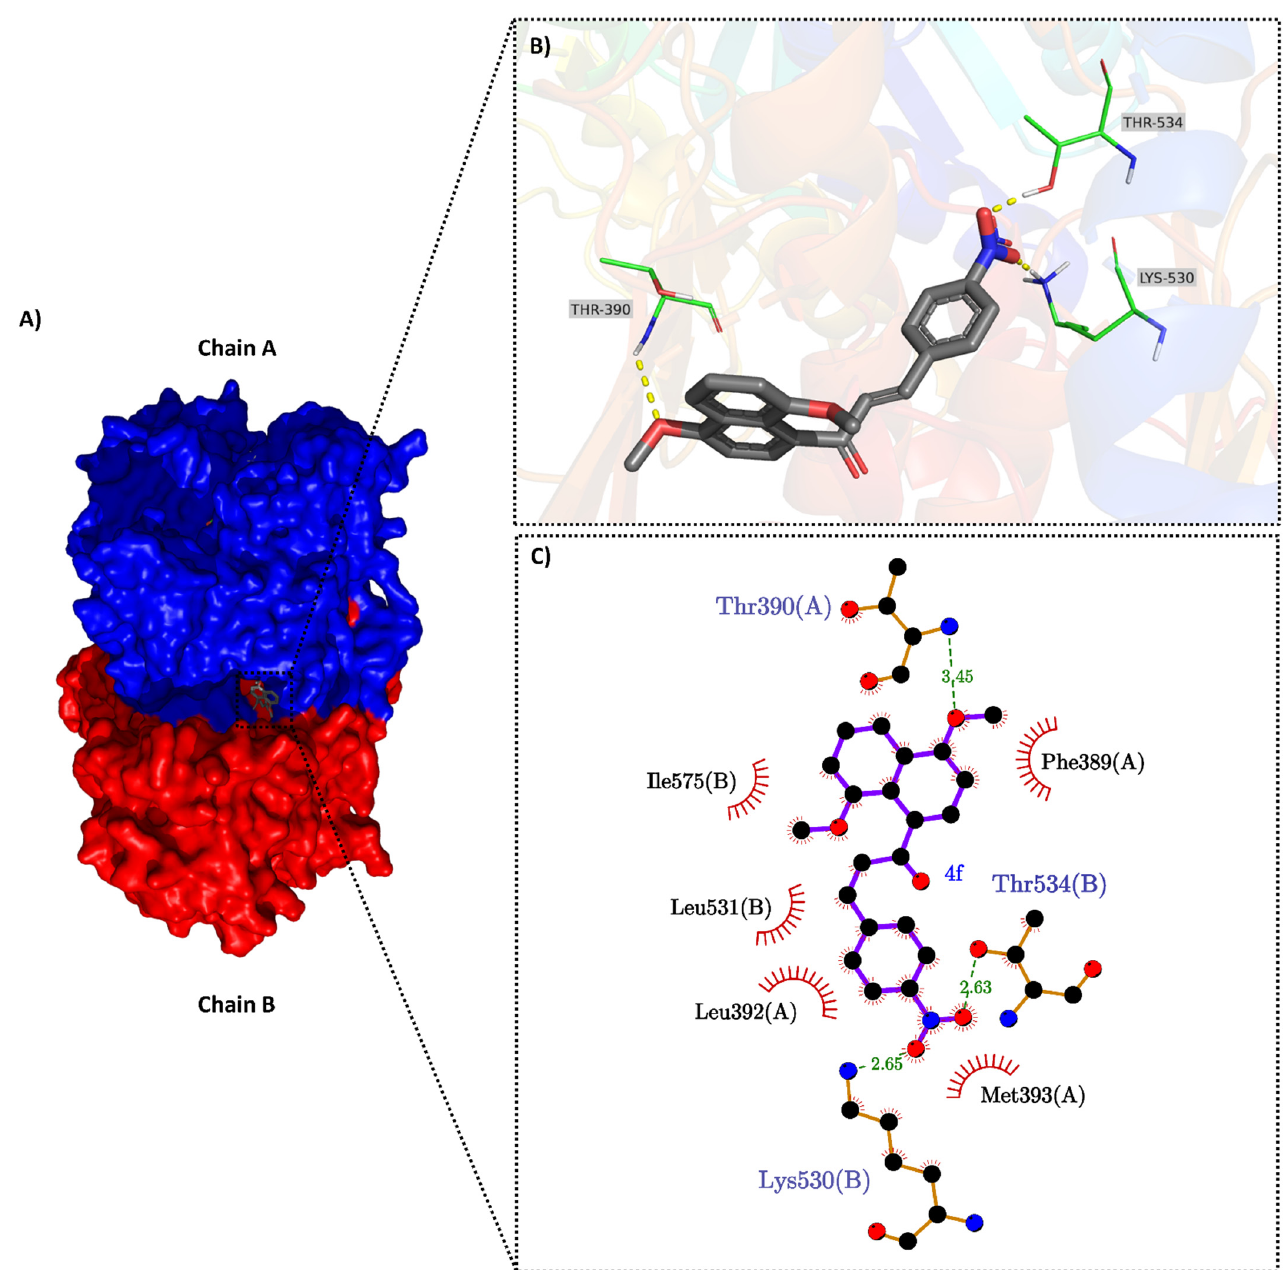
Figure 10. Protein-ligand interactions. ( A ) Surface representation of the dimeric form of TR. Chain A is blue, chain B is red, and ligand 4f is presented as gray sticks. ( B ) An enlarged view of the substrate-binding pocket. Residues interacting via hydrogen bonding are shown in lines. The hydrogen bonds with the ligand 4f are shown in yellow dashed lines. ( C ) 2D representation generated by LigPlot+ of probable interactions between compound 4f and residues from the catalytic domain of TR. Green dashed lines represent hydrogen bond interactions. The arcs with spokes represent non-ligand residues involved in hydrophobic contacts.